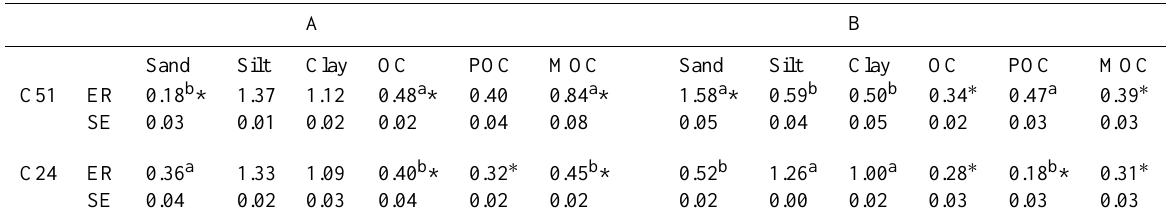
Table 4. Mean Enrichment Ratio (ER) and associated Standard Error (SE) for A and B profiles (taking topsoil 0–10cm as reference soil values).